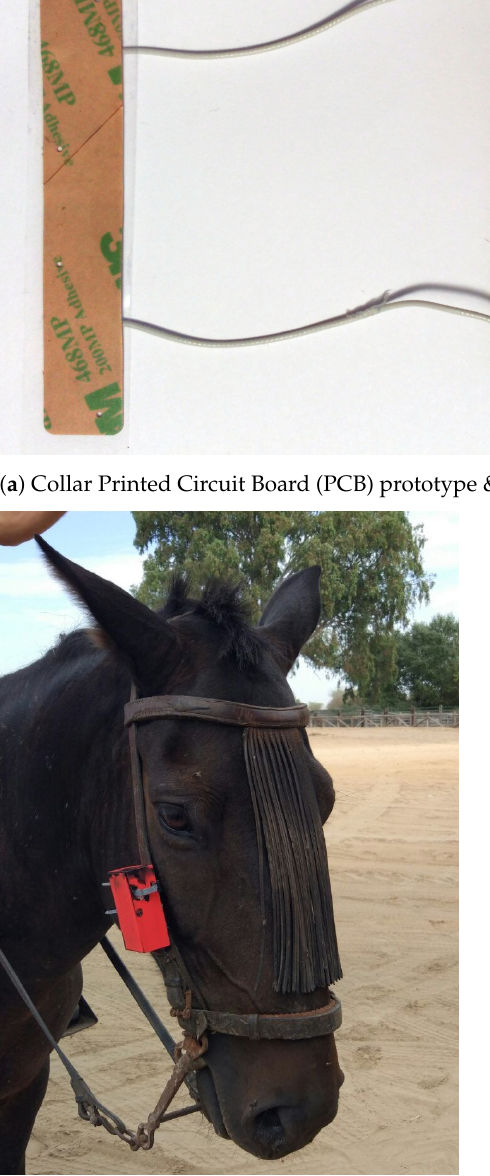
Figure 1. ( a ) From left to right: Antenova Asper 2.4 G/GNSS Antenna, and PCB front view, showing the microcontroller, the XBee module, and the GPS module. The IMU is under the XBee radio module, between the PCB and the module. ( b ) Horse with the collar device prototype